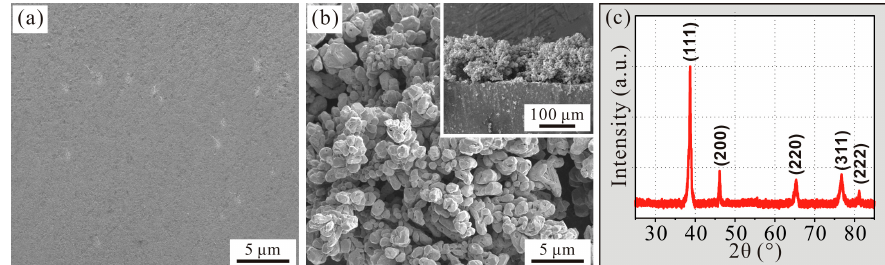
Figure 1. SEM images of ( a ) Al alloy substrate and ( b ) deposited sample. ( c ) XRD spectrum of deposited surface. The insert in ( b ) referring to cross-sectional image of deposited sample.